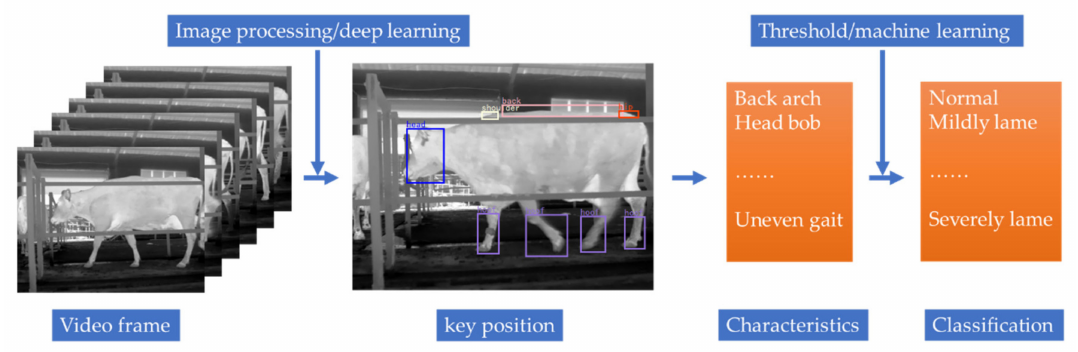
Figure 4. The process of detection